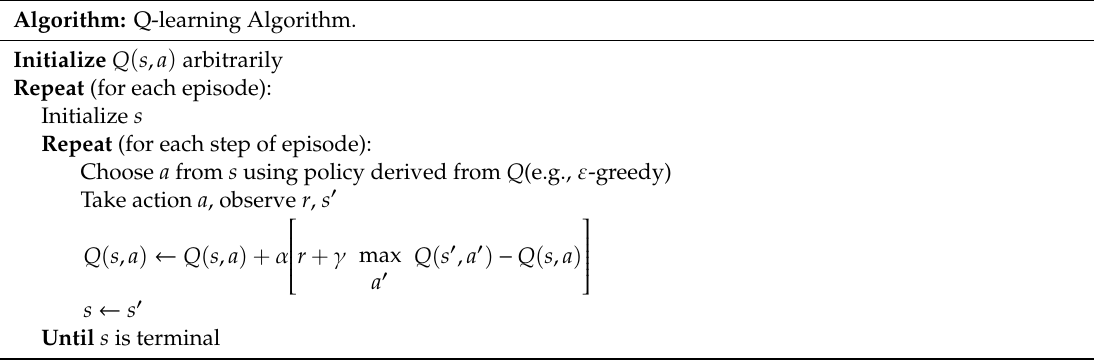
Table 4. Pseudo-code of the Q-learning algorithm.